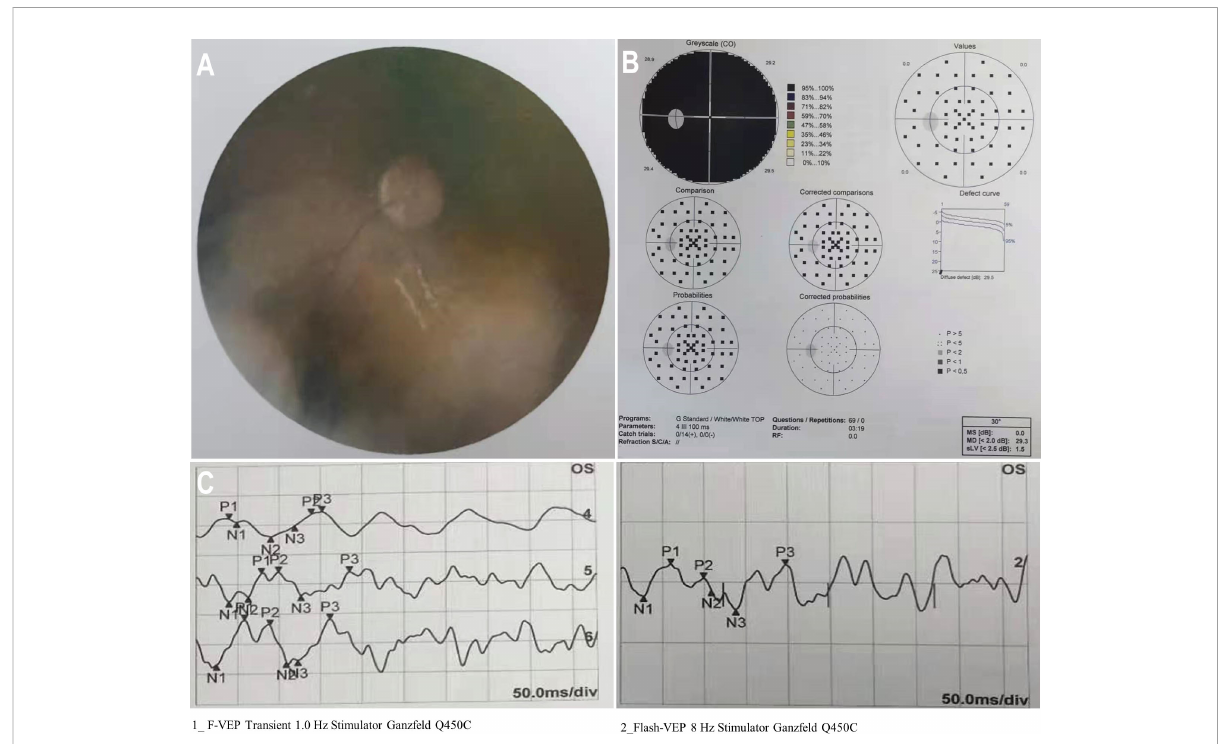
FIGURE 1 Preoperative condition of the left eye. (A) A funduscopic examination of the left eye revealed a hazy fundus. (B) Automated perimetry showed total visual fi eld defect in the left eye. (C) F-VEPs of the left eye showed a reduced